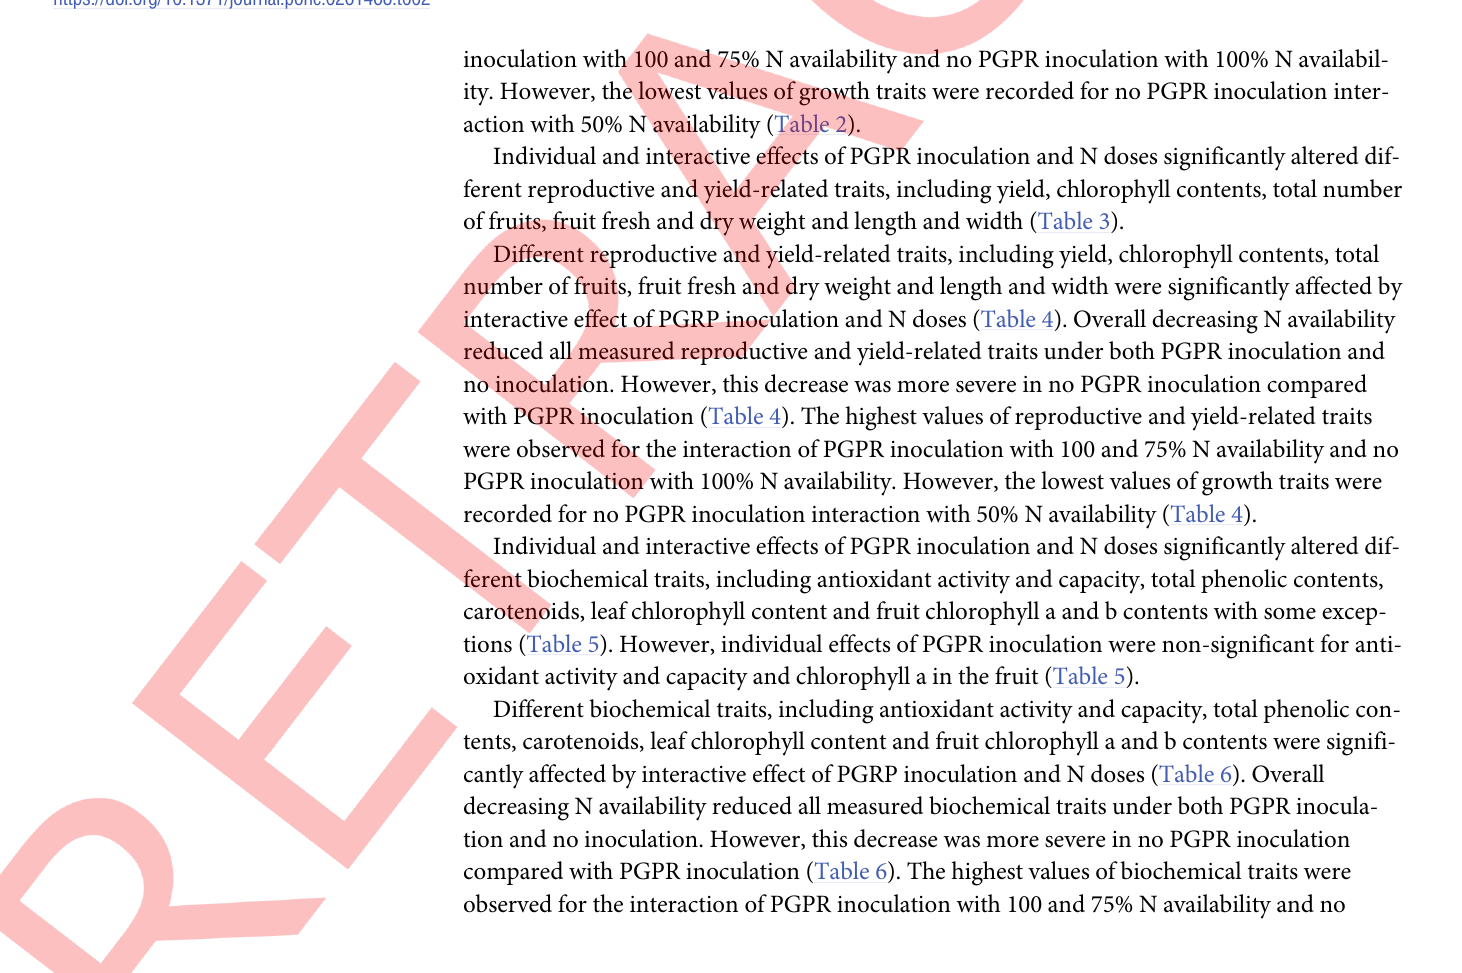
Here, B 1 = no bacteria inoculation, B 2 = bacteria inoculation, F 1 = 50% N, F 2 = 60% N, F 3 = 70% N, F 4 = 75% N, F 5 = 80% N, F 6 = 100% N, Means followed by different letters within a column statistically differ from each other (p >